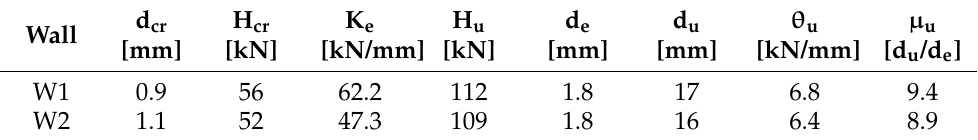
Table 3. Results of bilinear idealization for plain walls W1 and